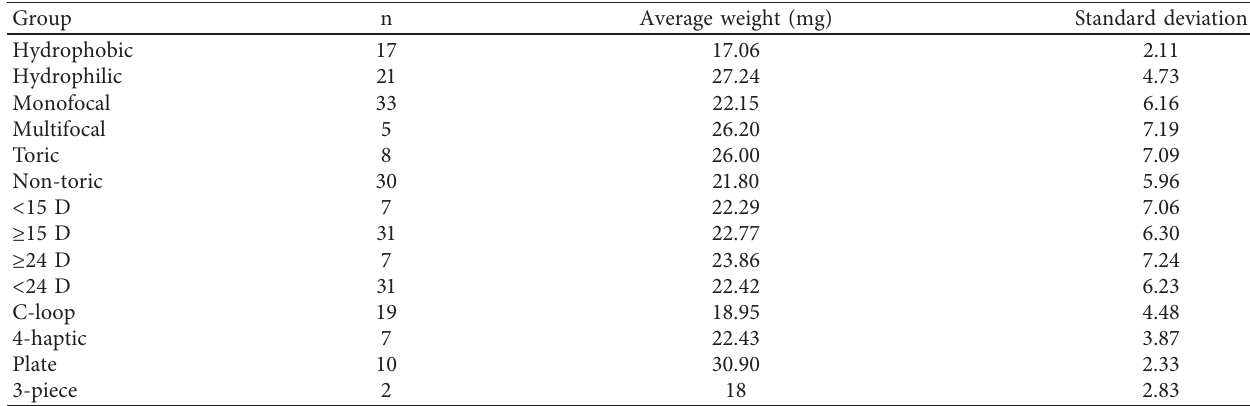
Table 2: Average values according to the different characteristics